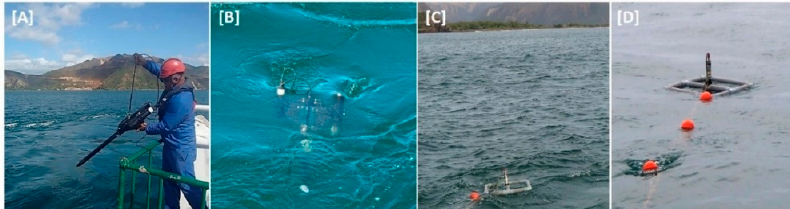
Figure 2. Photographs of the Satlantic Hyperpro-II free-falling radiometer ( A , B ) and the TriOS-RAMSES in-water radiometer attached to a floating polyvinyl chloride (PVC) frame ( C , D ).